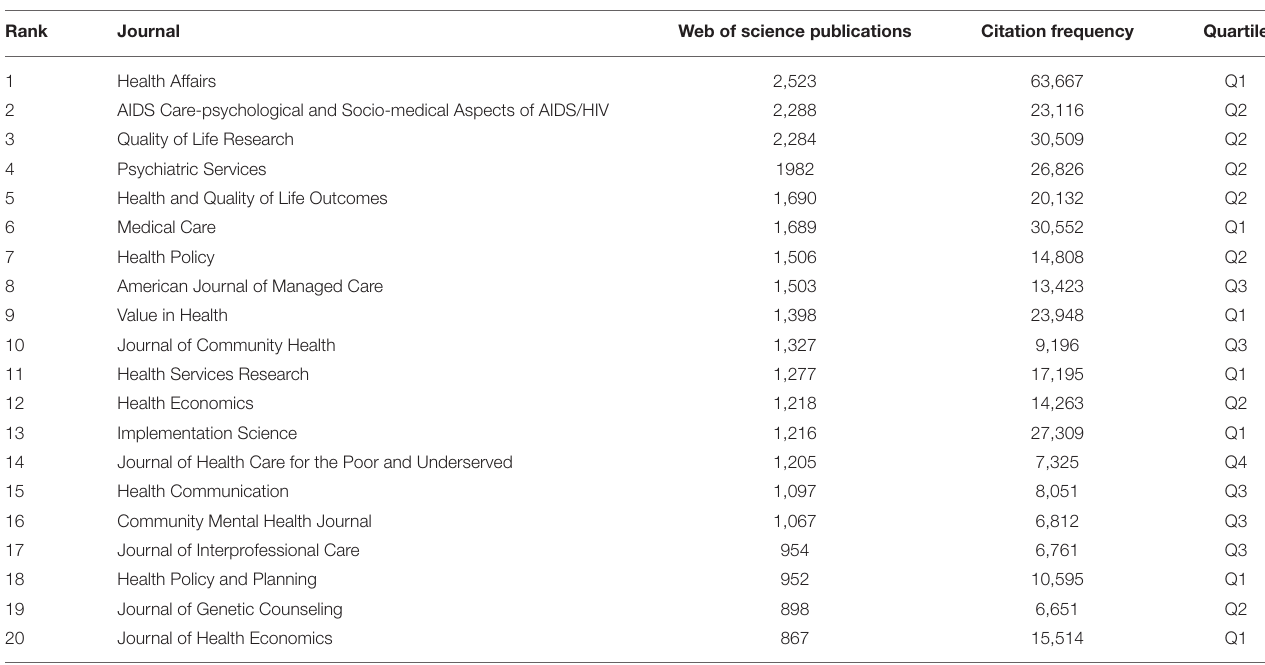
TABLE 2 | Journals of publications in health policy and